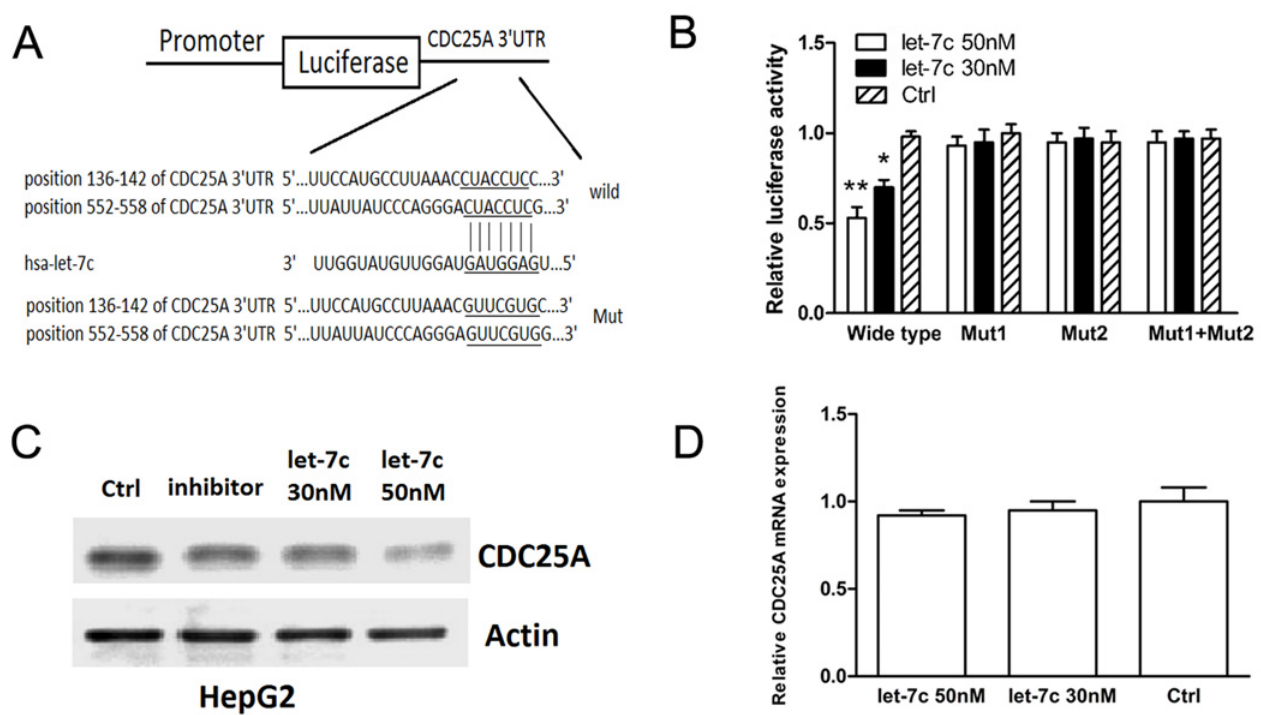
Fig 5. Let-7c targets CDC25A in HCC cells. (A) Firefly luciferase reporter vectors containing the CDC25A wild-type (pmiR-CDC25A-3 0 -UTR-wt) or mutant (pmiR- CDC25A-3 0 -UTR – mut) 3 0 -UTR were generated and co-transfected into HepG2 cells along with either the let-7c agomir or negative control to identify CDC25A targets. The 3 0 UTR of CDC25A mRNA contained two complementary sites for the seed region of let-7c. (b) Wild: wild-type; Mut: mutated. The seed sequence is underlined. (B) Relative luciferase activity was analyzed after the reporter plasmids or control reporter plasmid were co-transfected with let-7c into HEK-293 cells. Representative experiments are shown. (C) Western blot assays of the endogenous CDC25A protein level in HepG2 cells transfected with the let-7c agomir, negative control or let-7c inhibitor. (D) Real-time PCR assay of CDC25A mRNA expression in HepG2 cells transfected with the let-7c agomir or negative